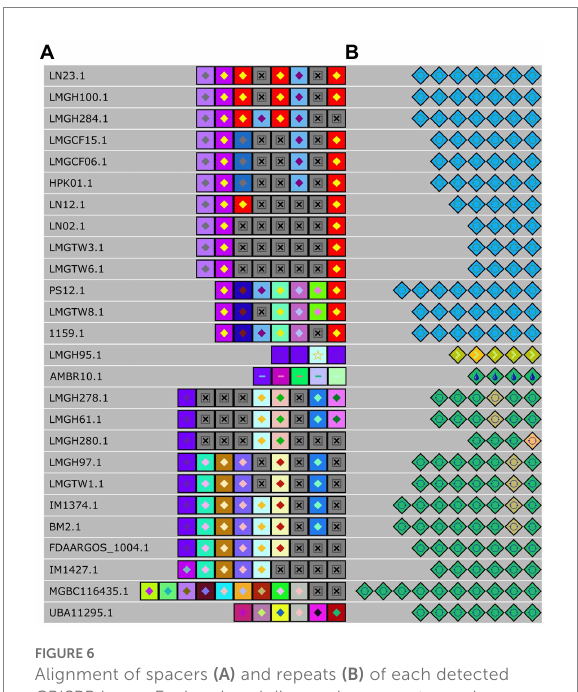
FIGURE 6 Alignment of spacers (A) and repeats (B) of each detected CRISPR locus. Each colored diamond represents a unique repeat, and each colored square represents a unique spacer in the CRISPR-Cas system. Grey “x” boxes show missing